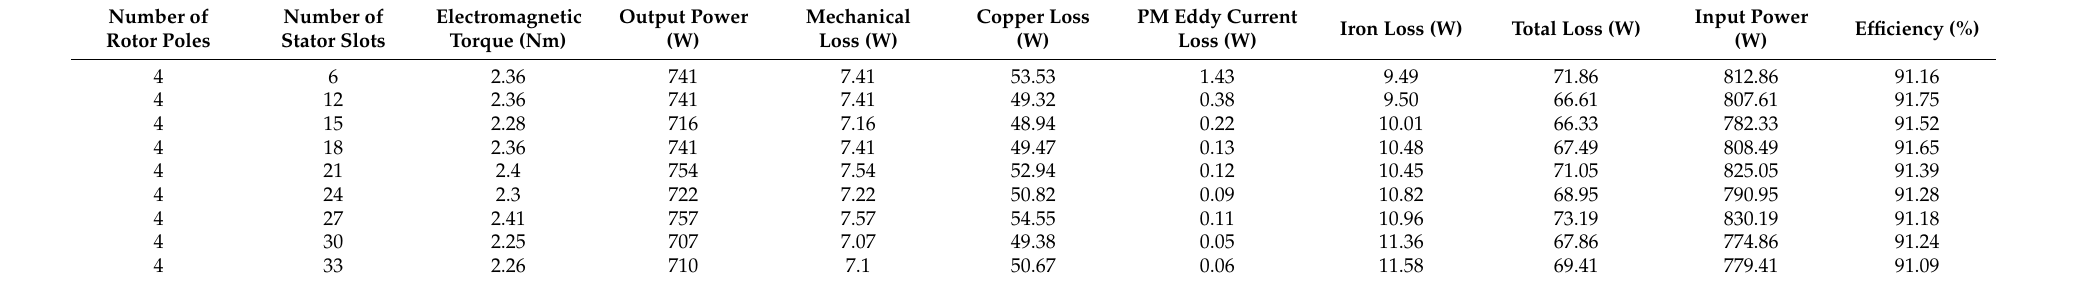
Table 8. Various losses and efficiency when the number of rotor poles is 4 and the number of stator slots takes different values. Number of Rotor Poles